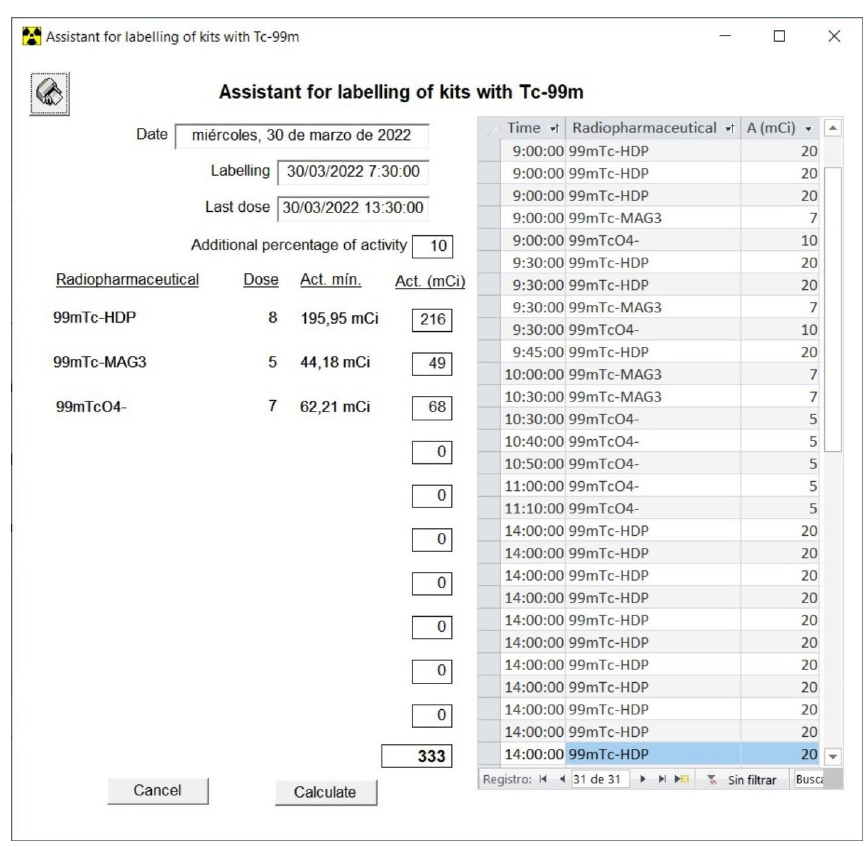
Fig. 7 Assistant for labelling of cold kits with 99mTc in the Labelling